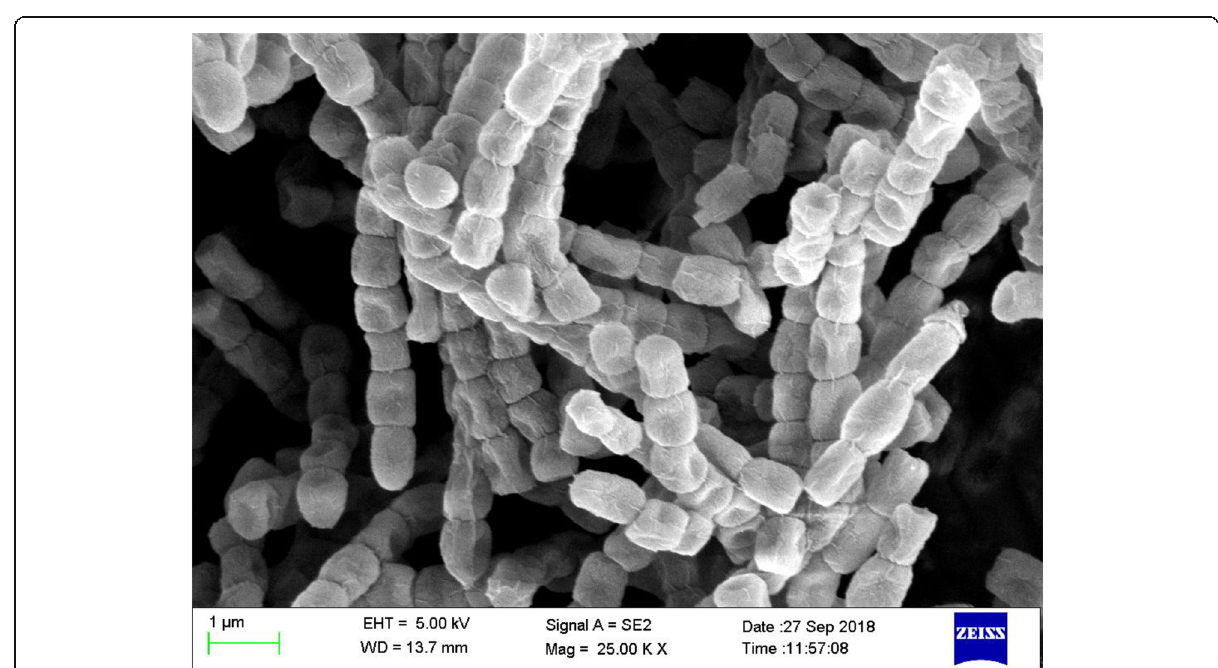
Fig. 2 Scanning electron micrograph showing spore ornamentation in Streptomyces sp.